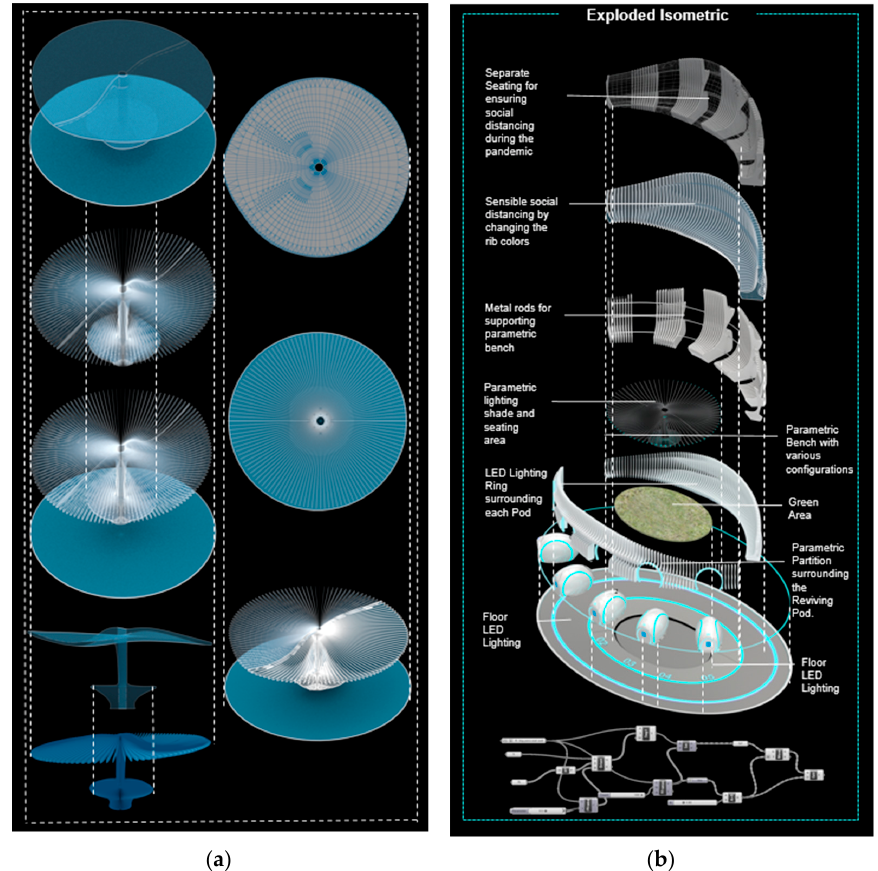
Figure 14: ( a ) Exploded isometric view showing the proposed layout for five Reviving Pods with parametric shade and surrounded by parametric partitions/Grasshopper definitions for the para- metric unit; ( b ) isometric views, elevation, and top views illustrating the parametric shade and seat (designed by the authors).